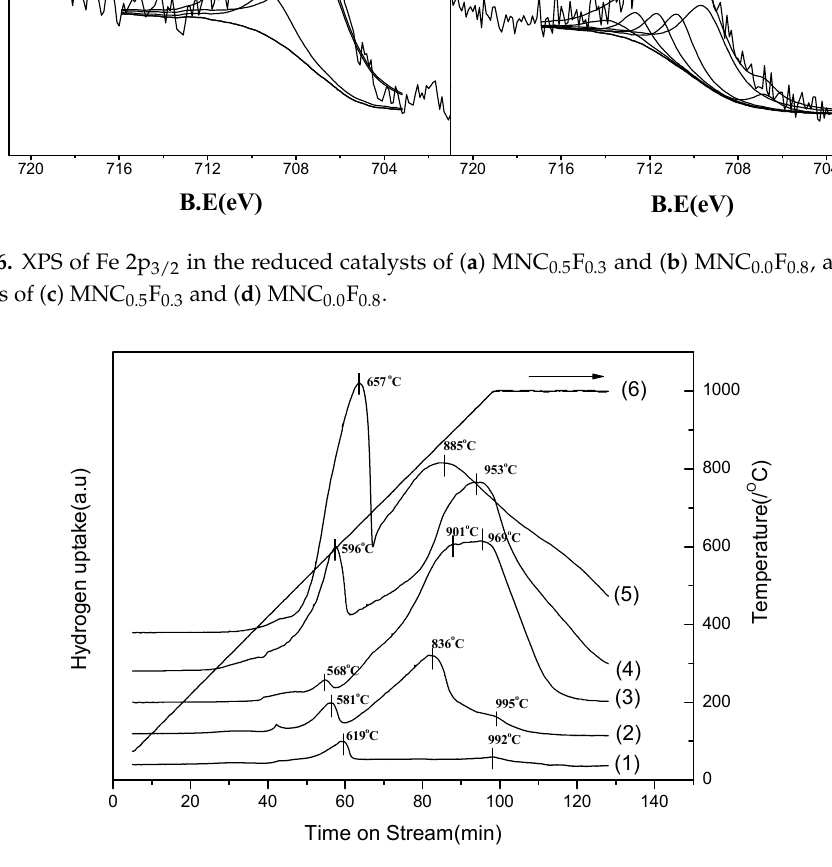
Figure 7. Profiles of temperature-programmed reduction of MNCF catalysts: (1) MNC 0.8 F 0.0 ; (2) MNC 0.7 F 0.1 ; (3) MNC 0.5 F 0.3 ; (4) MNC 0.3 F 0.5 ; and (5) MNC 0.0 F 0.8 ; (6)